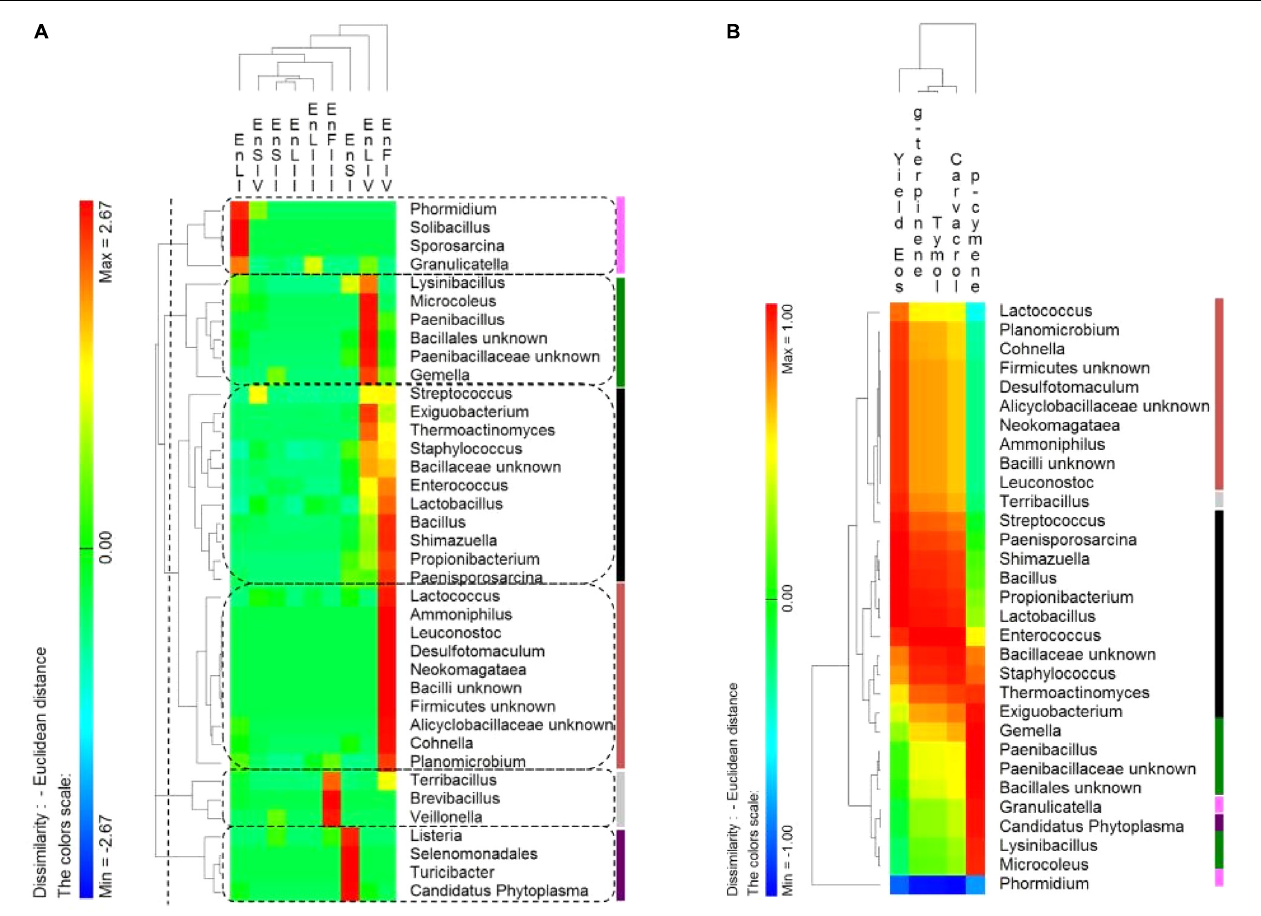
FIGURE 6 | (A) Pseudo heat map summarizing the distribution of endophytic (En) Firmicutes genera on leaves, stems and flowers of Origanum vulgare L. plant during the early vegetative (I), late vegetative (II), blooming (III), and full-flowering (IV) stages. The color key defines the percentages of OTUs normalized row-by-row. Clusters are separated by the vertical dashed lines and highlighted by different colors. (B) Pseudo heatmap showing correlation (Pearson correlation) between the relative abundance of endophytic (En) Firmicutes genera found at the full-flowering (IV) stages, and the yield in Essential oils (Eos) and the most abundant EOs (%). A color scale ranging from a minimum of – 1 (negative correlation) to a maximum of 1 (positive correlation) was used. Clusters, as settled on the (A) , were highlighted by different